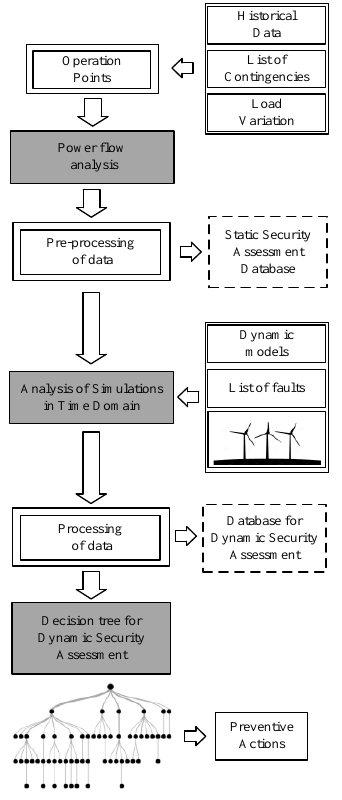
Figure 5. Offline steps for the decision tree creation process.